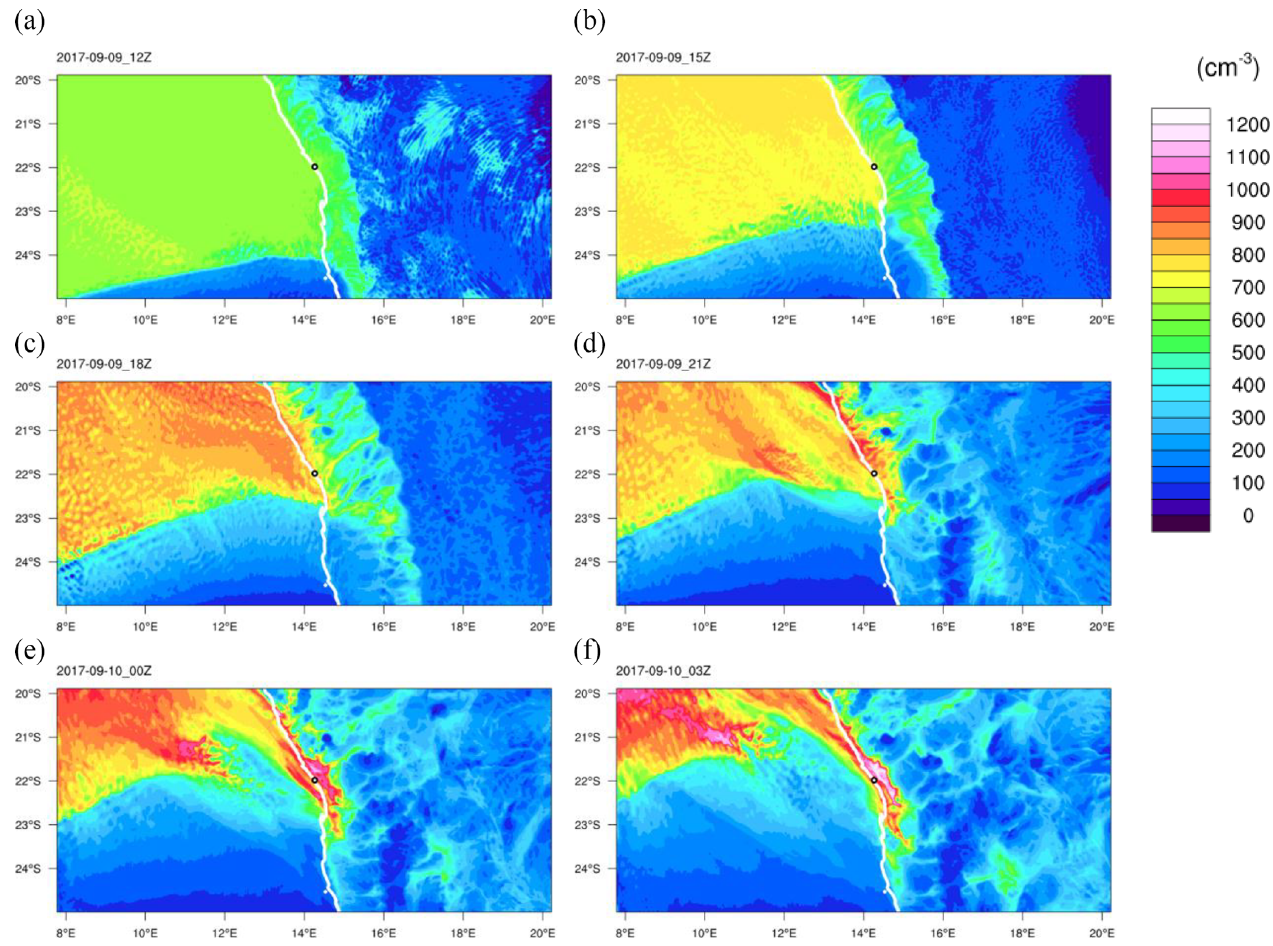
Figure 11. Evolution of water-friendly CCN concentration (cm − 3 ) for the event on 10 September 2017 for scenario CCN_300. The black dot is Henties Bay. Time is in UTC (site is UTC +